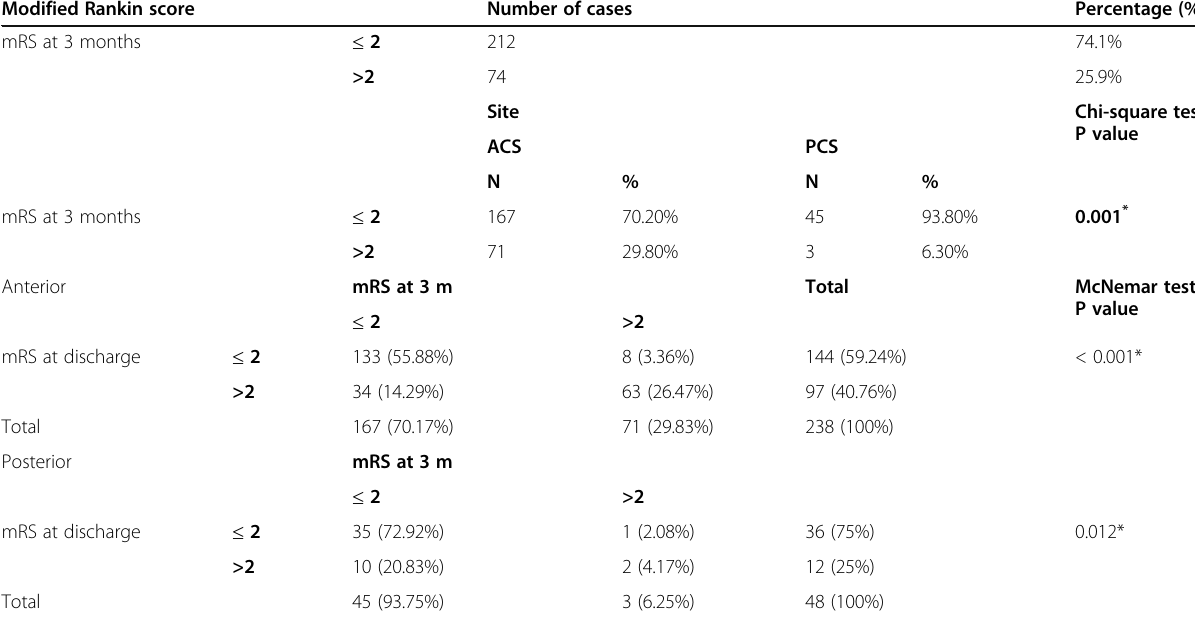
Table 3 Distribution of the mRS within all study cases, comparison of mRS at discharge and 3 months Modified Rankin score